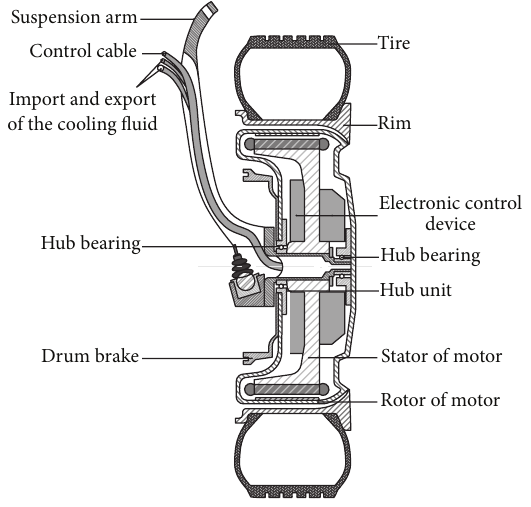
Figure 1: Basic structure of the electric